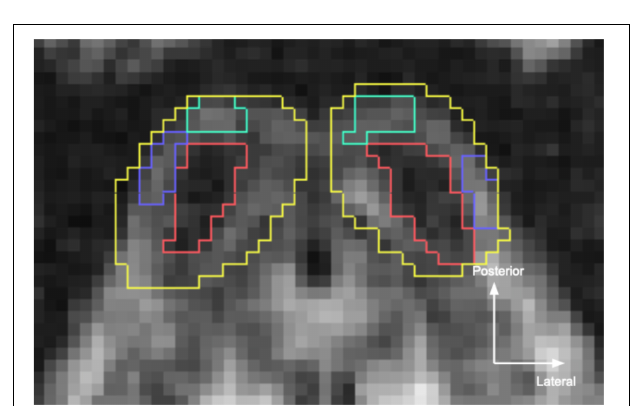
FIGURE 2 | Inferior colliculus (IC) segmentations in the sub-millimeter in vivo dataset. Yellow, overall IC; red, central nucleus (ICc); turquoise, dorsal nucleus (ICd); blue, external nucleus (ICx). Segmentations were hand drawn on the 760 µ m isotropic diffusion MRI quantitative anisotropy